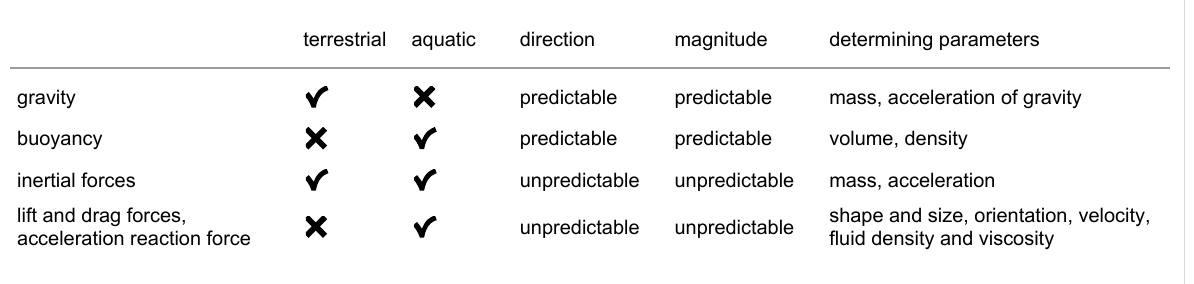
Table 1: Forces of detachment in terrestrial and aquatic environments. Relative importance: – usually important, – usually not